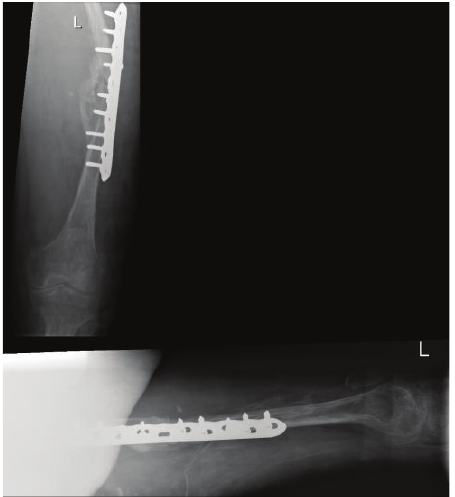
Figure 6: AP and lateral radiograph of the left femur after 10 weeks of LIPUS